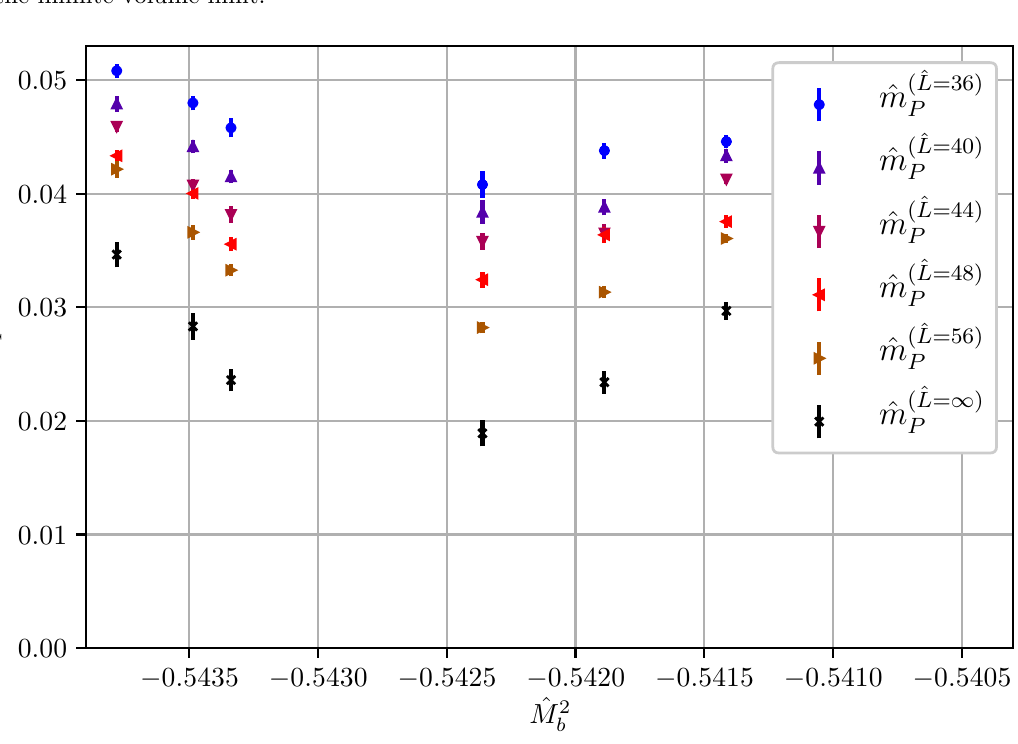
Table 1 . Results of the pole mass in lattice units, ^ m to the in(cid:12)nite-volume limit.